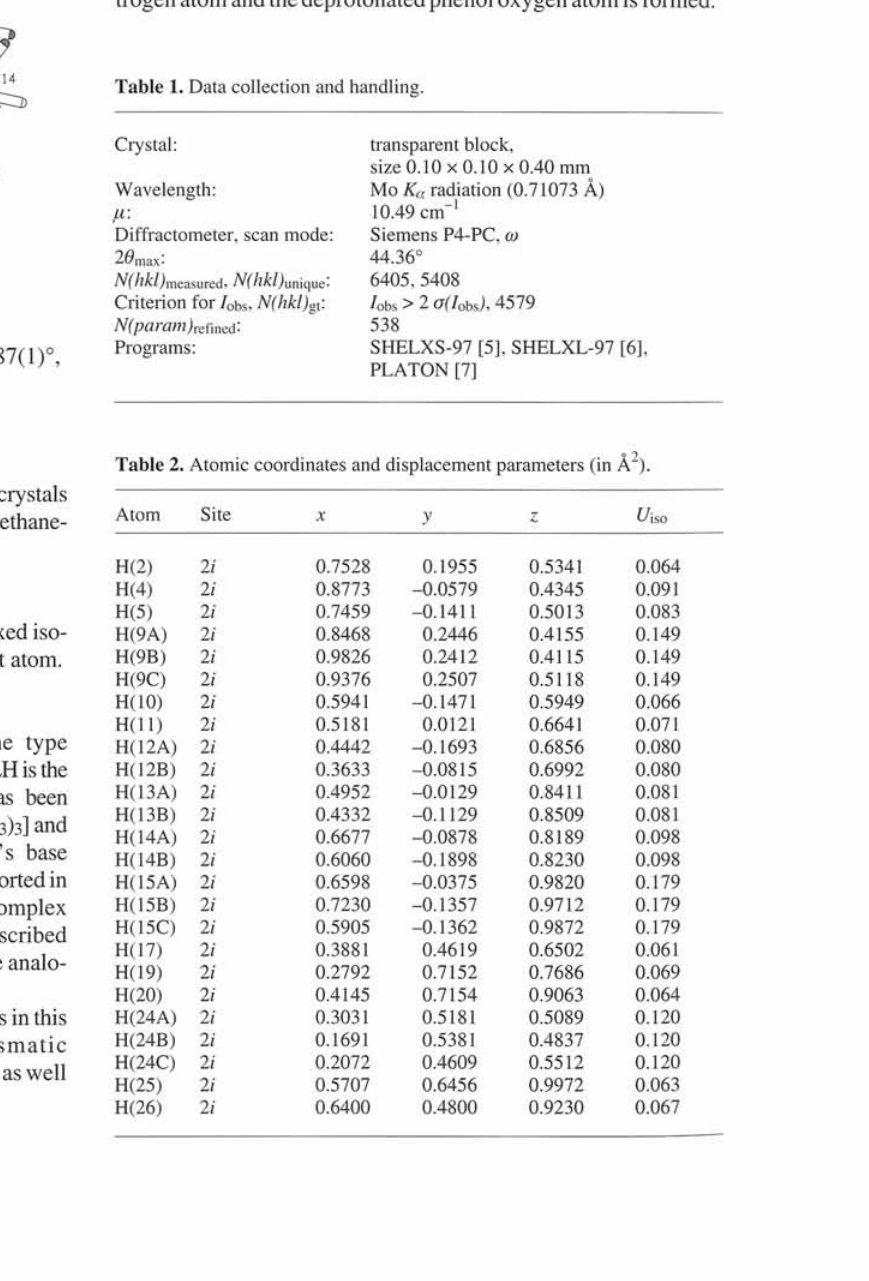
Table 1. Data collection and handling.